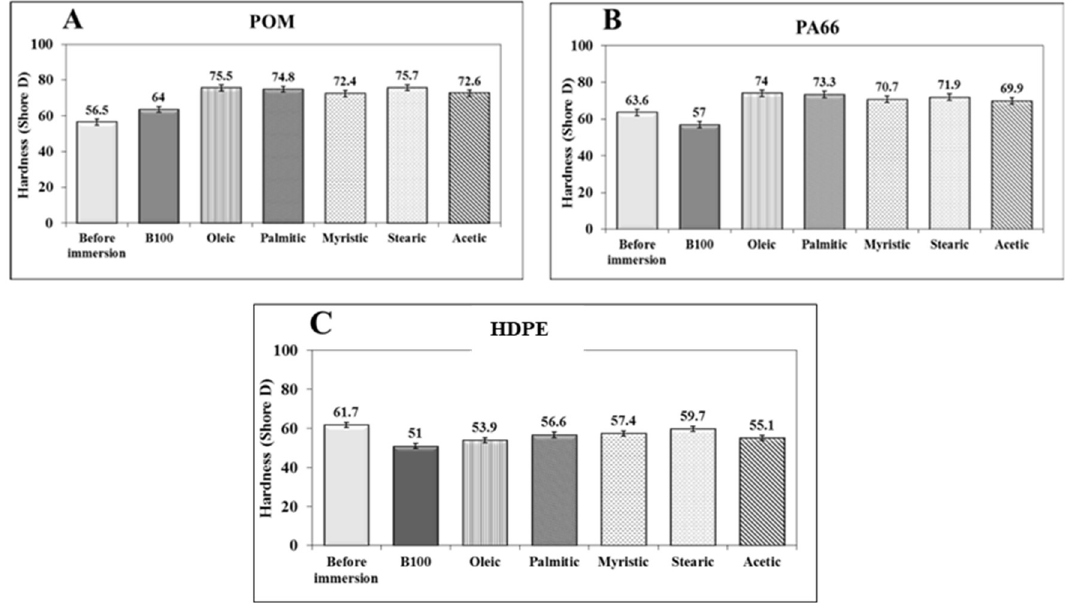
Figure 12. Hardness variation of the polymeric materials after immersion in B100 and B100–acid blends. ( A ) HDPE, ( B ) PA66 and ( C ) POM. Polymers 2018 , 10 , x FOR PEER REVIEW